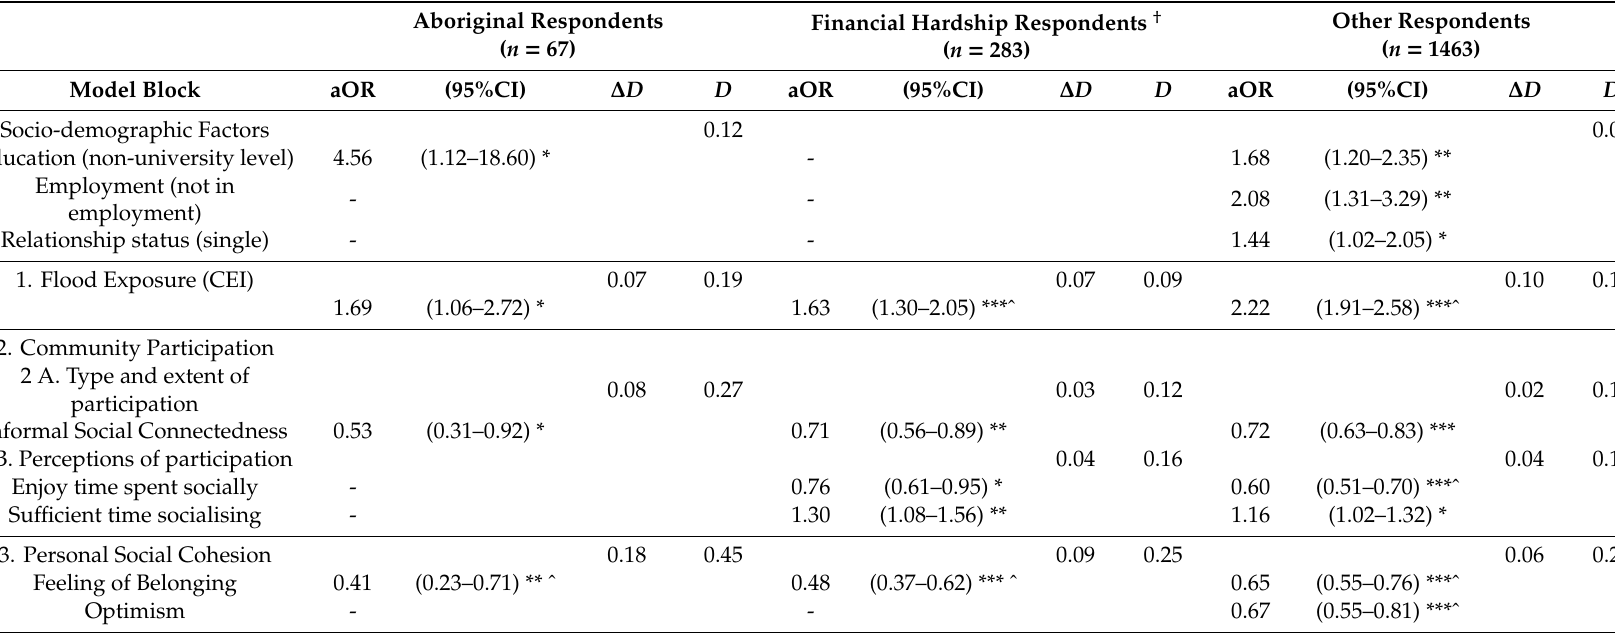
Table 7. Parameter estimates and associated statistics of multiple hierarchical logistic models predicting flood-related probable PTSD for each respondent group, controlling for sociodemographic factors ‡